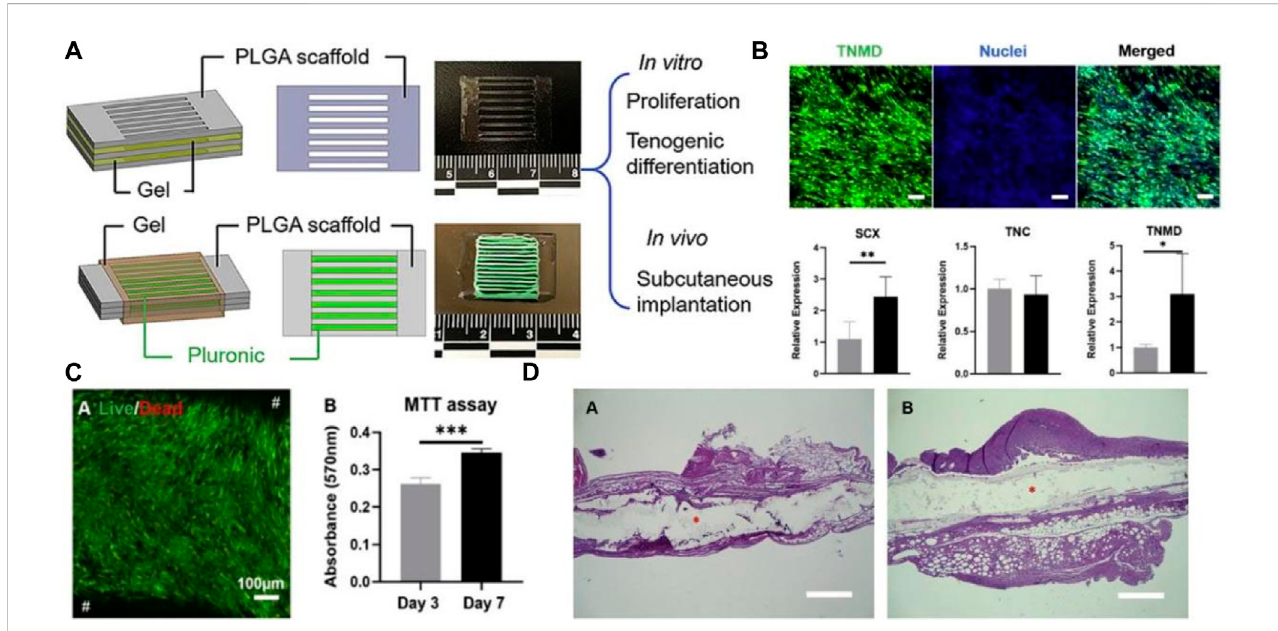
FIGURE 4 (A) Schema of PLGA scaffold models with collagen- fi brin hydrogel. (B) collagen fi brin hydrogels induce cell differentiation; (C) Effect of collagen fi brin hydrogels on cell activity and proliferation; (D) Post-implantation H&E staining of collagen fi brin hydrogels. Reproduced with permission (Jiang et al.,